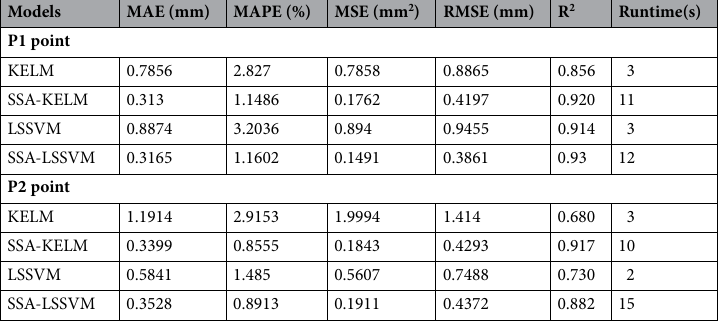
Table 14. Evaluation indicators of four models under P1 and P2 monitoring points.